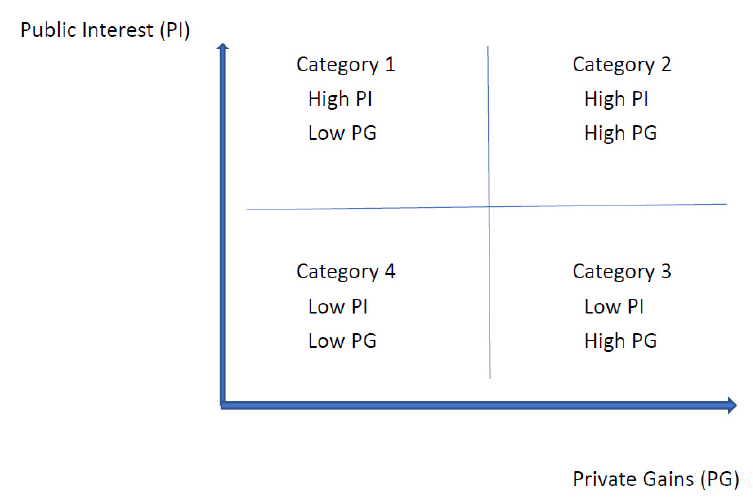
Figure 1. Interplay of Public Interest and Private Gains.